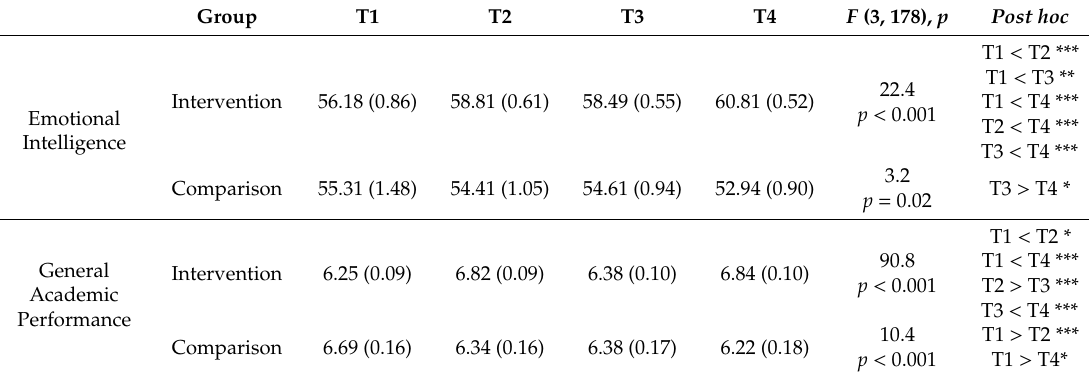
Table 1. Mean and standard error (SEM) for the Emotional Intelligence and Academic Performance variables at T1-T4, F multivariate and post hoc